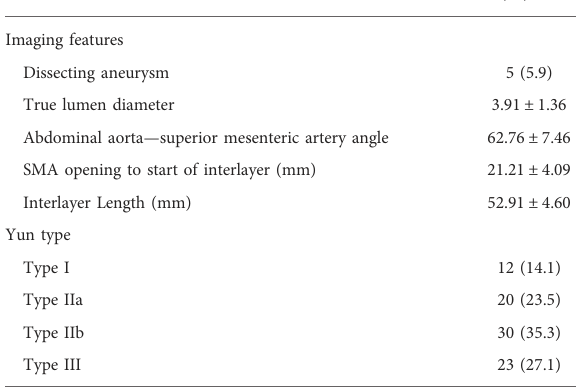
TABLE 2 The imaging data of the